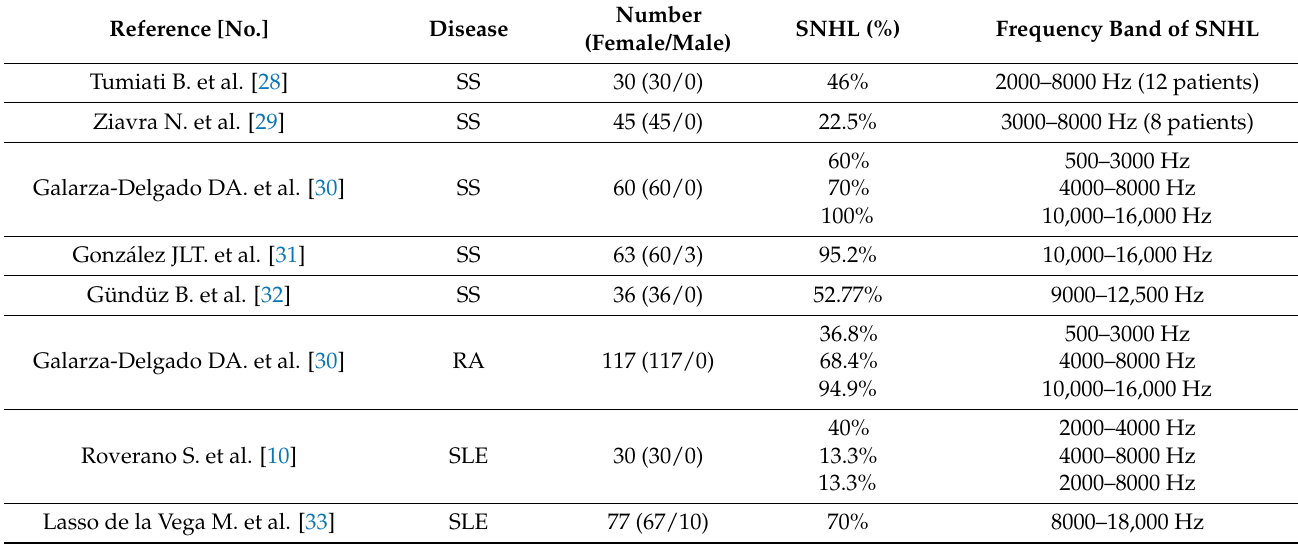
Table 1. Summary of the previous reports on SNHL in SS, RA, and